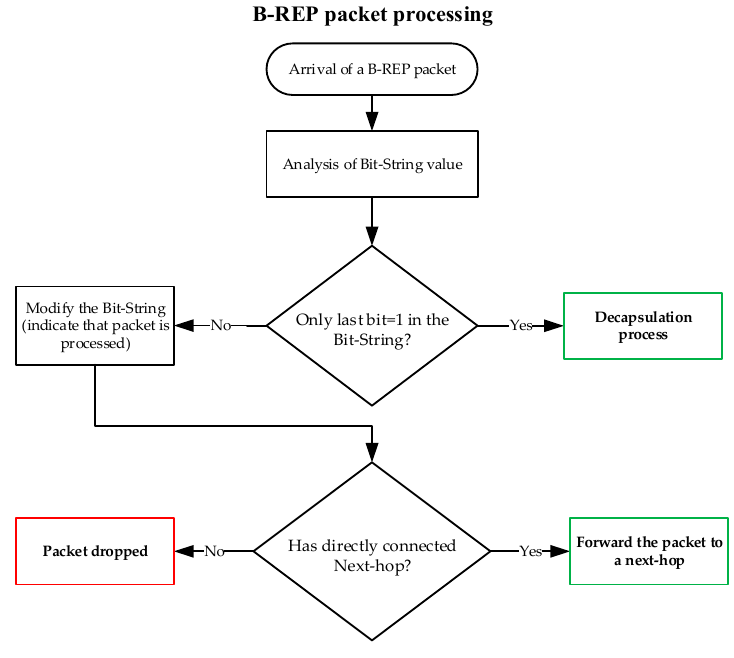
Figure 10. Diagram of B-REP activation and error response process.